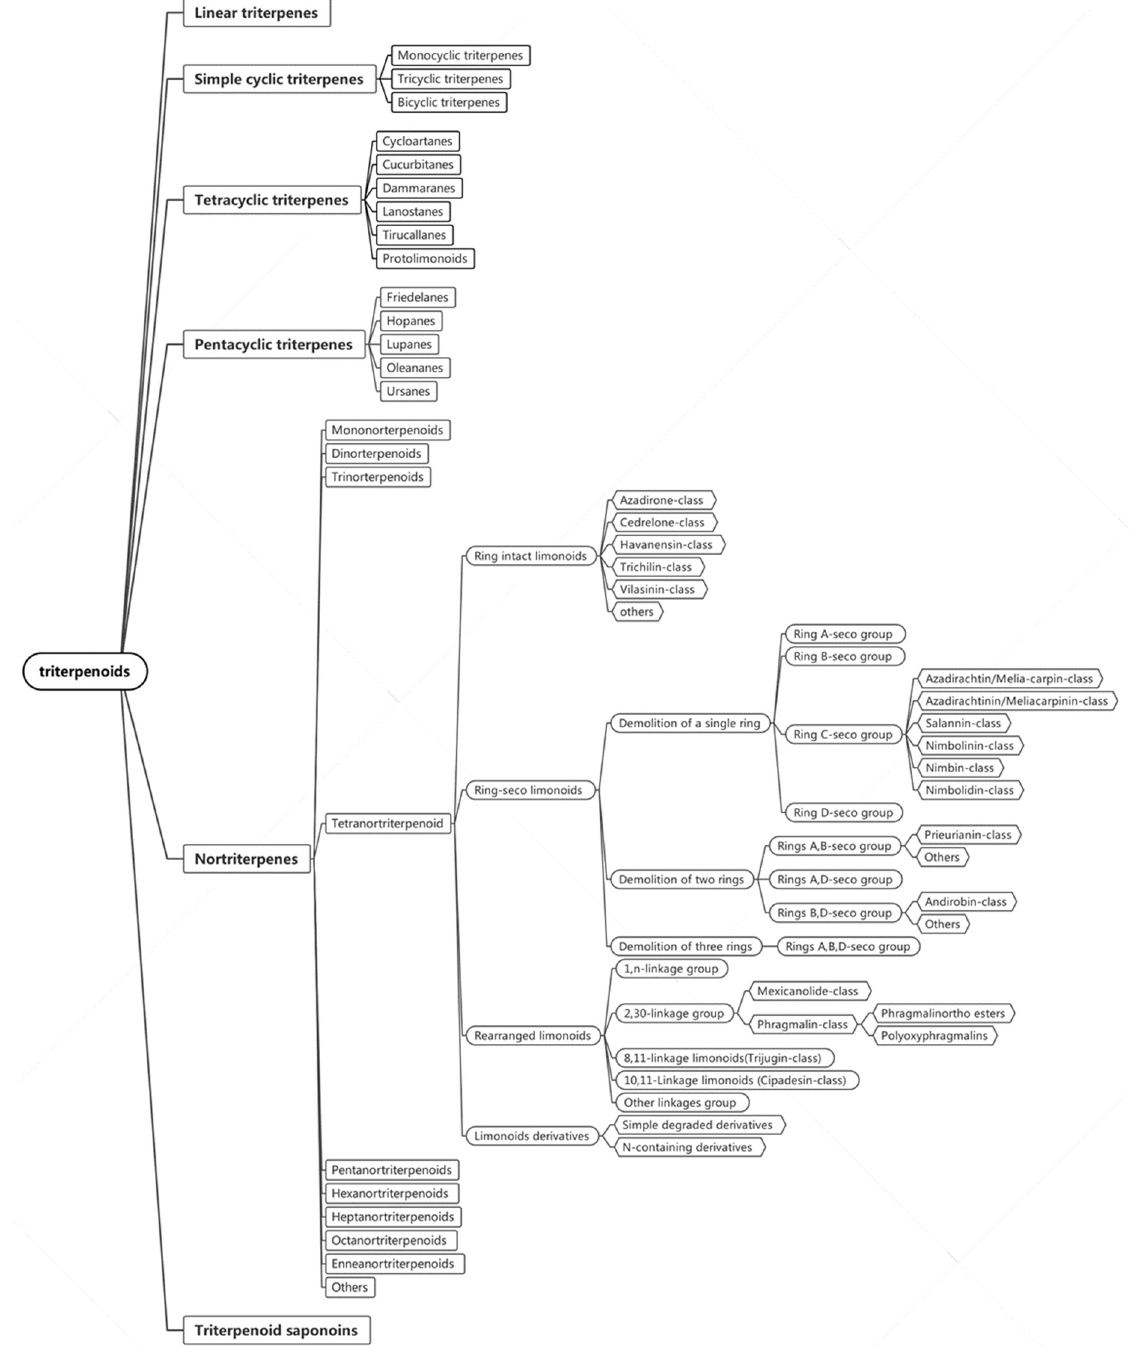
Figure 1. The structural classification of triterpenes.